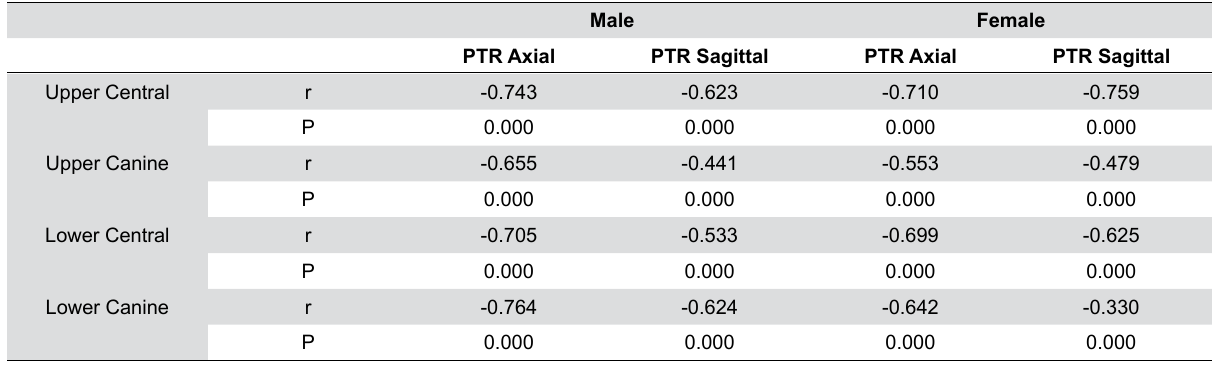
Table 2- Pearson’s coefficient of correlation between chronological age and physiological ratio